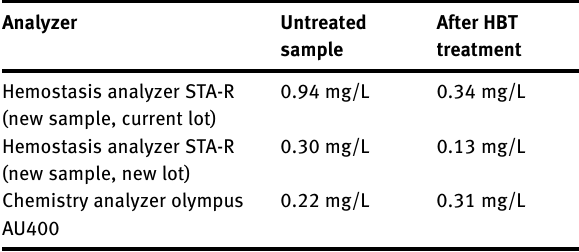
Table  : D-dimer a results obtained from the new sample before and after HBT